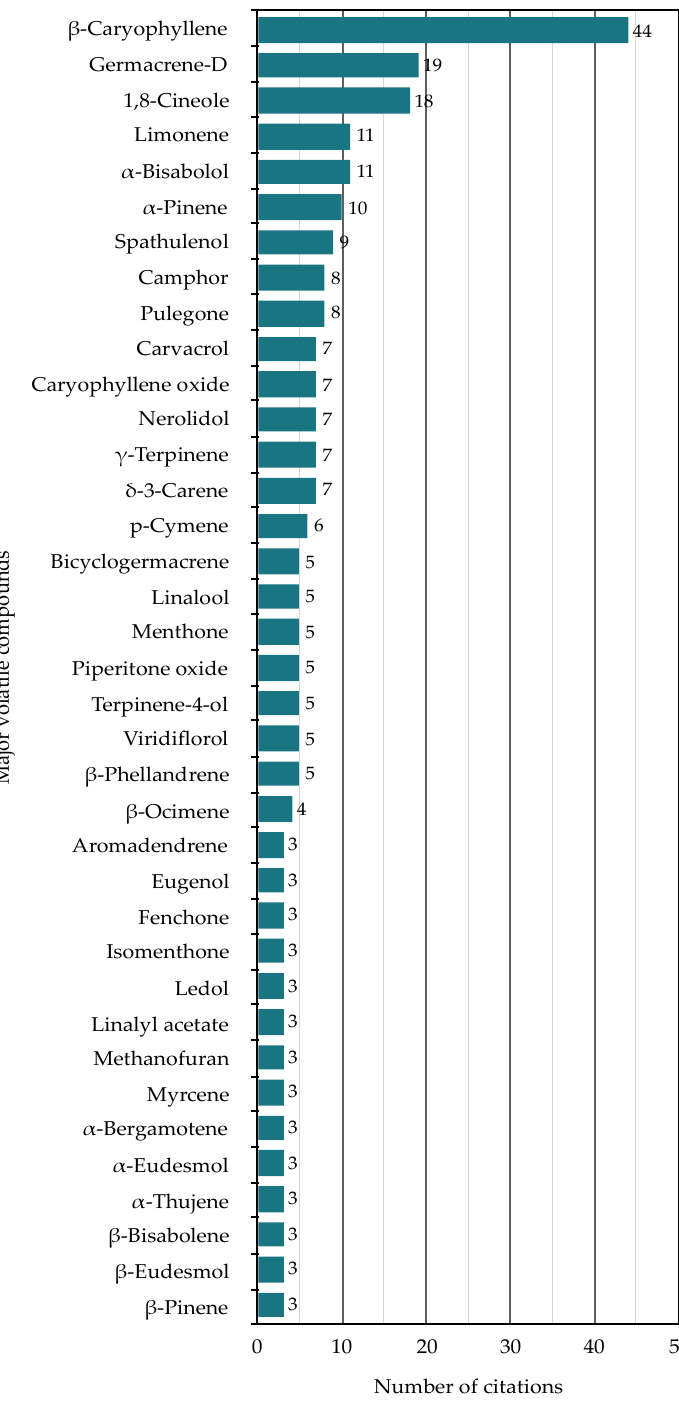
Figure 6. Summary of the frequency of citation of major essential oil compounds (i.e., those repre- senting more than 10% of the composition of the oil) reported from the genera of southern African Lamiaceae. Only compounds with three or more citations are shown.